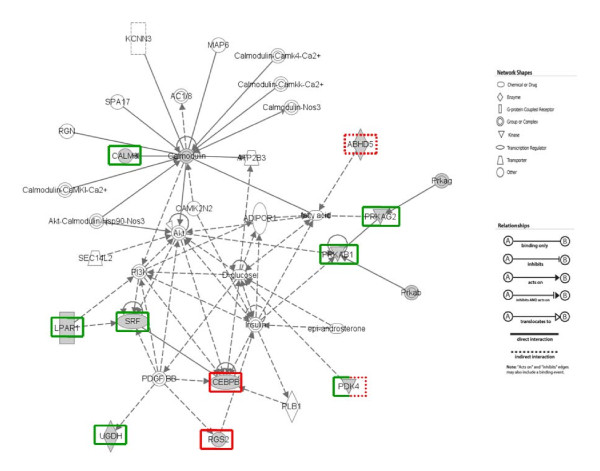
Network in which several genes identified as differential between Fat (F) and Lean (L) and/or G+ and G- muscles are involved. The biological interpretation of expression data was performed using Ingenuity Pathway Analysis 7.0 (IPA, Ingenuity Systems Inc., Redwood City, CA). The genes included in the analyses were shown to be differential between F and L and/or G+ and G-. This gene network is involved in several molecular and cellular functions including lipid and carbohydrate metabolism, molecular transport, small molecule biochemistry, and cell morphology. The differential genes surrounded by a dashed line originated from the comparison between F and L birds, and those surrounded by an unbroken line from the comparison between G+ and G- muscles originating from the F2 cross between the F and L lines. The genes over-expressed in muscles with high (F or G+) and low glycogen content (L or G-) are circled in red and green, respectively.